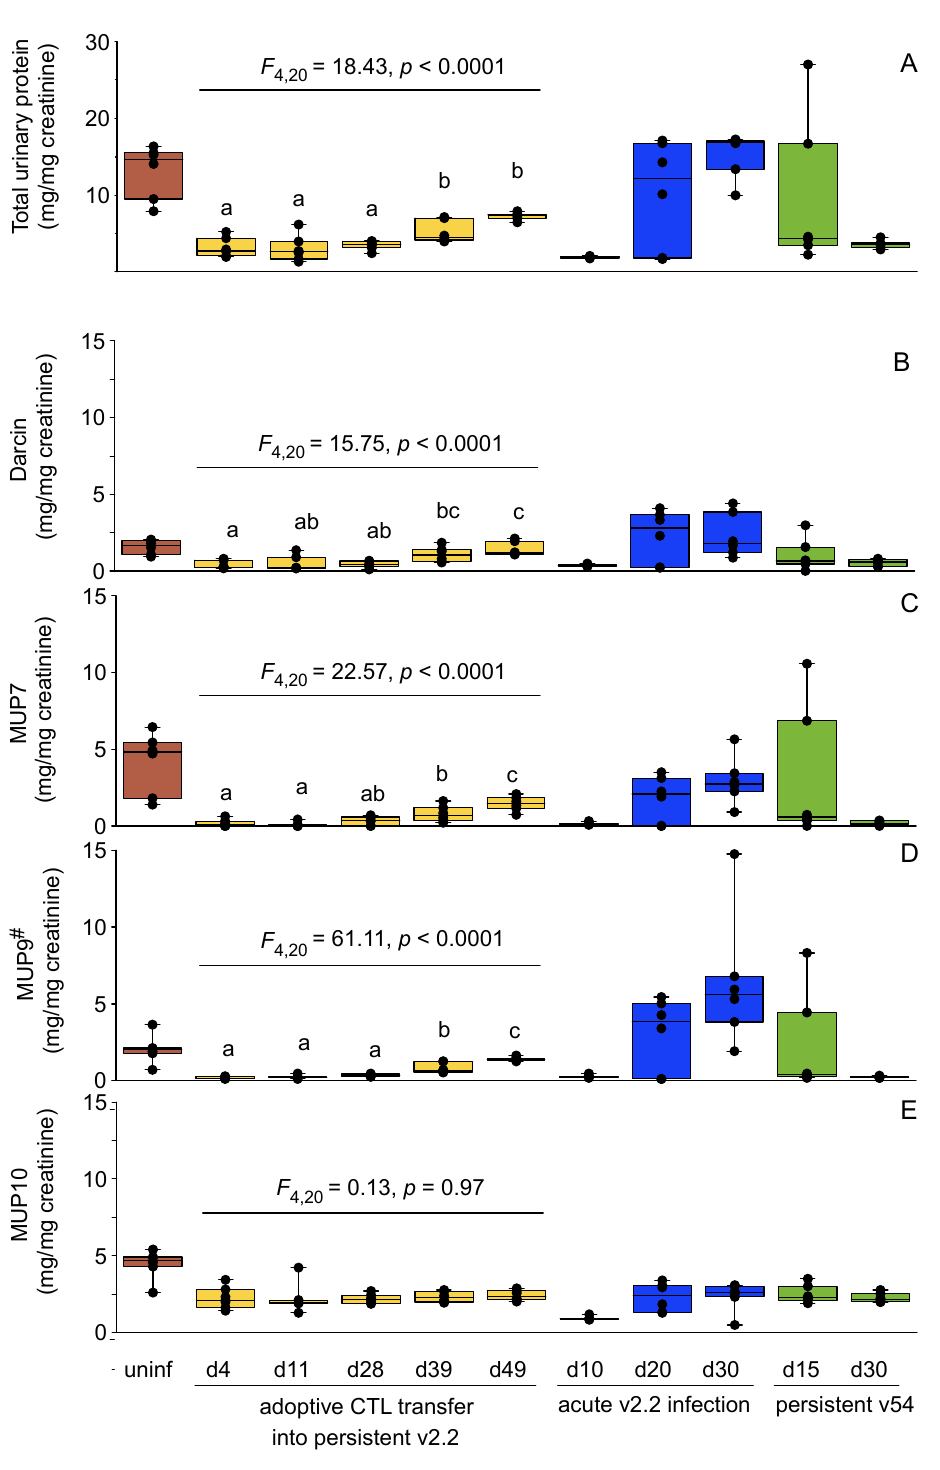
Figure 4. Changes in MUP output during and after CTL clearance of persistent or acute LCMV infection. Males with persistent LCMV v2.2 infection from birth (yellow) were tracked through viral clearance by adoptive CTL transfer (N = 7, see Figure 3 for viral titers). This was compared with males of the same age undergoing acute v2.2 infection and natural clearance (blue), inoculated with a persistent v54 infection (green) or uninfected (red) (N = 6 males per time point). ( A ): total urinary protein corrected for urine dilution. ( B – E ): amounts of each major mass peak (darcin, MUP7, MUP9 # and MUP10, respectively), corrected for urine dilution. Different letters above each column for adoptive CTL transfer experiment indicate time points that differ significantly using Bonferroni post-hoc comparisons ( p < 0.05). MUP9 # is used to refer to the group of central MUPs of very similar or identical mass (see Figure 1).